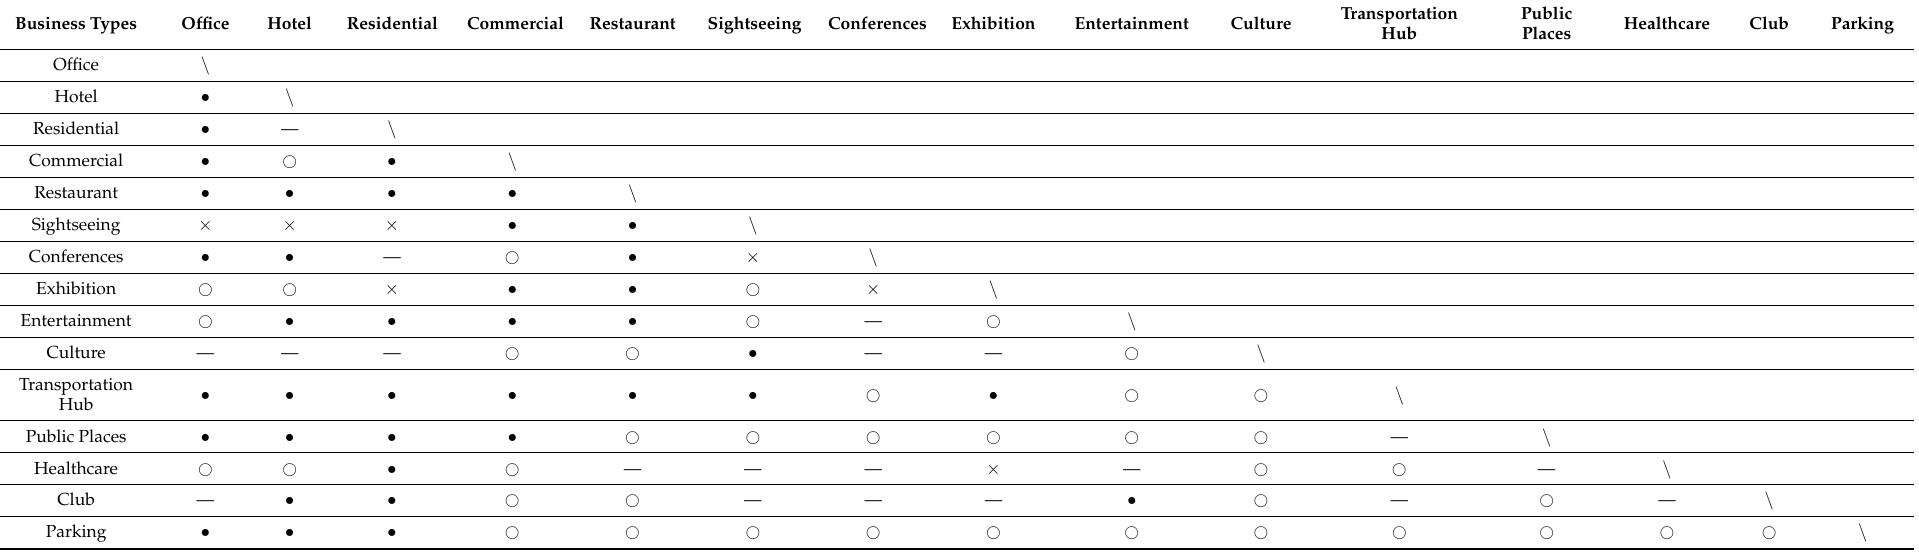
Table 1. The degree of the synergy of different business